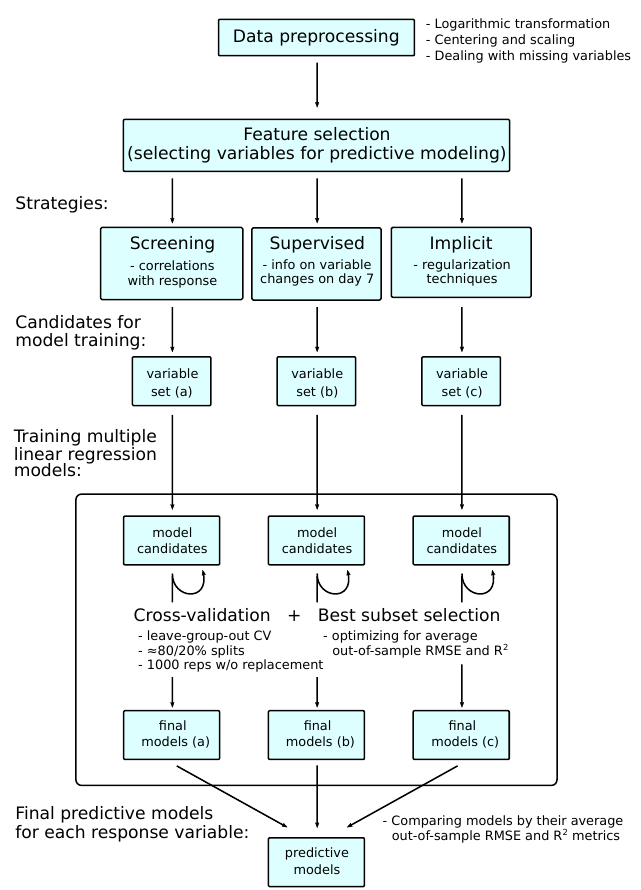
Figure 3. The workflow for building predictive models of post-vaccination immune response, which includes screening for potential predictors with three different screening strategies and comparing the candidate models using